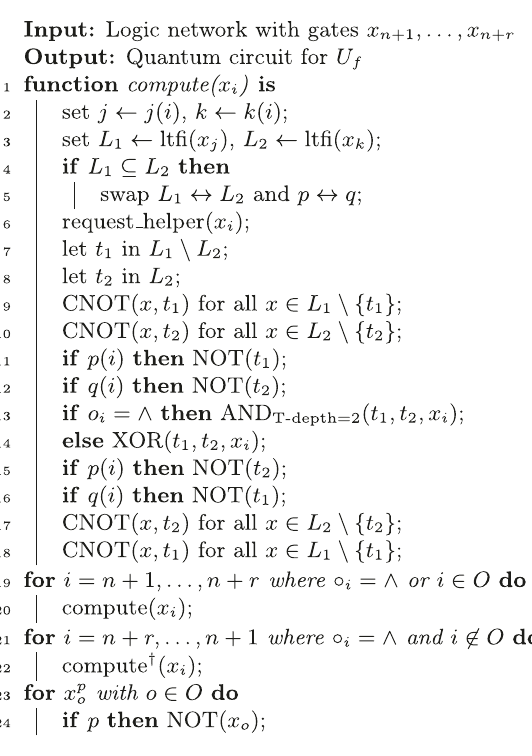
Algorithm 1 . Low T-count compilation algorithm.